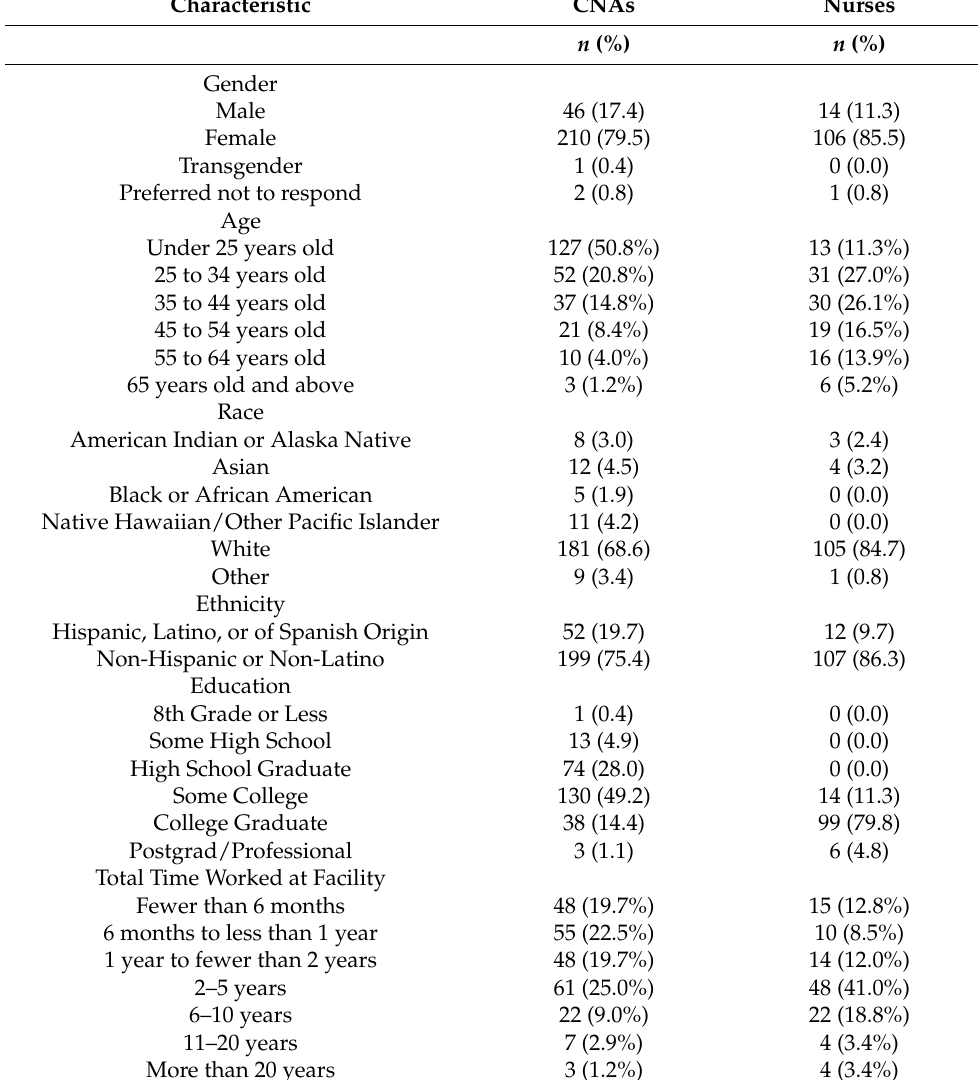
Table 1. Demographics of Survey